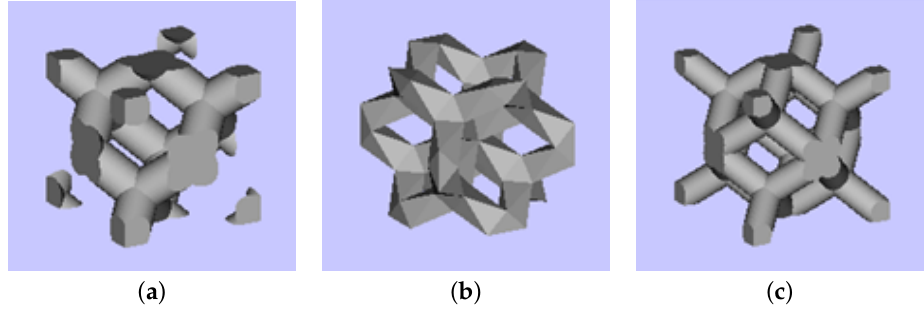
Figure 2. Basic cells of trabecular structures: ( a ) diamond (D30), relative density 30%, ( b ) Dode Thick (DT), ( c ) rhombic dodecahedron (RD30, relative density 30%).